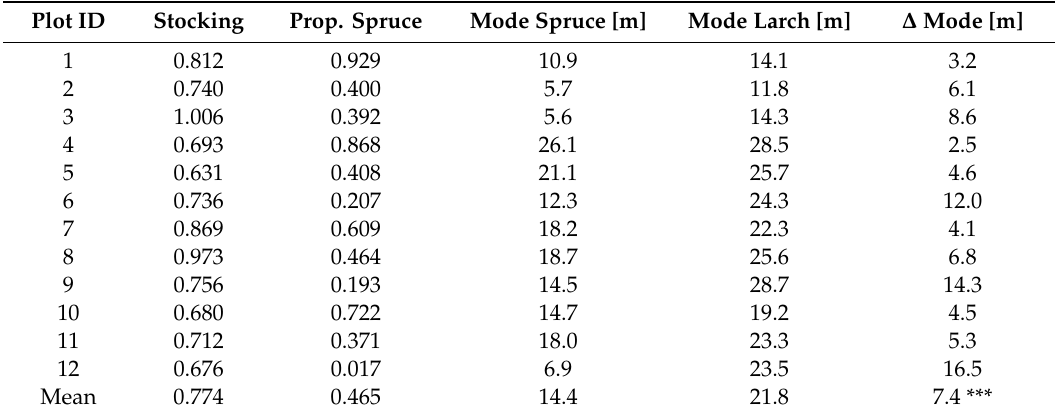
Table 6. The variation of the modes by species, and ∆ Mode at the stand level. R 2 for ∆ Mode and Stocking is 0.0018 (linear), the one for ∆ Mode and Prop. Spruce (potential) is 0.85. *** indicating the